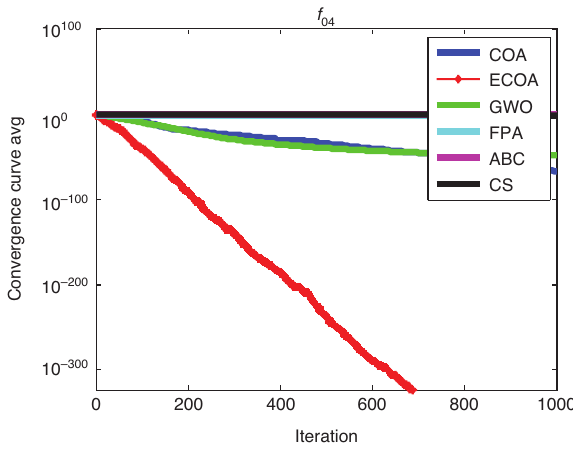
Figure 7: D = 30, Evolution Curves of Fitness Value for f